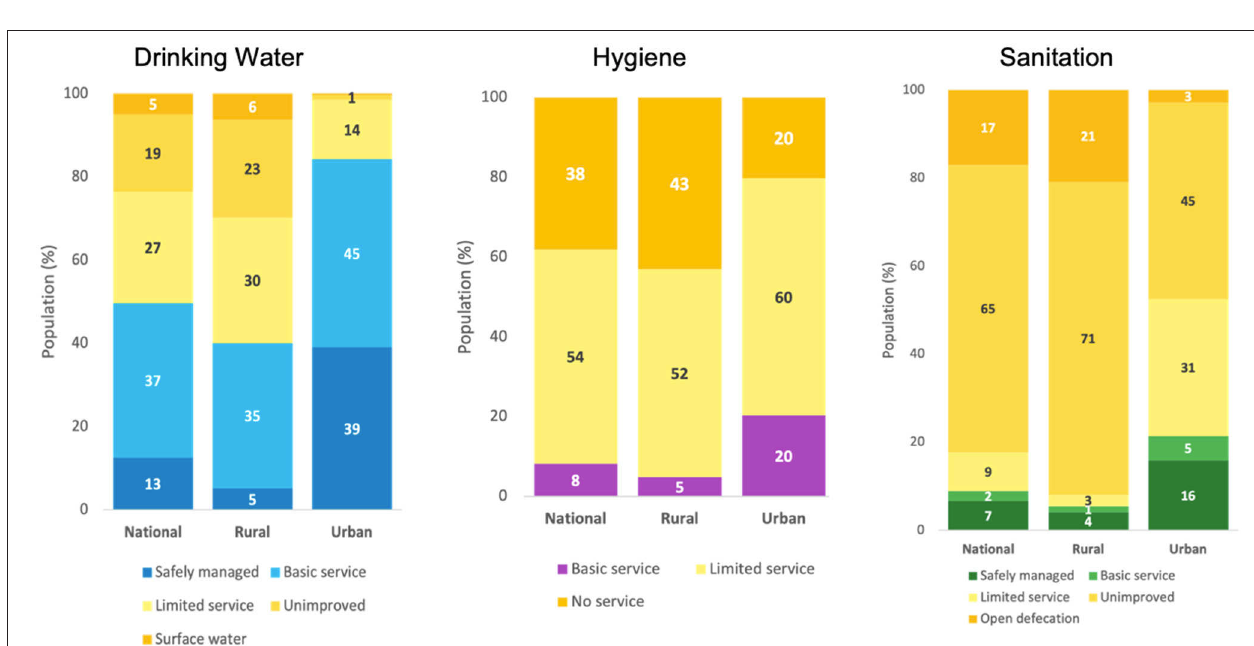
FIGURE 3 | Access to drinking water, hygiene and sanitation services in Ethiopia on national, rural and urban level (Source: WHO/UNICEF, 2021).